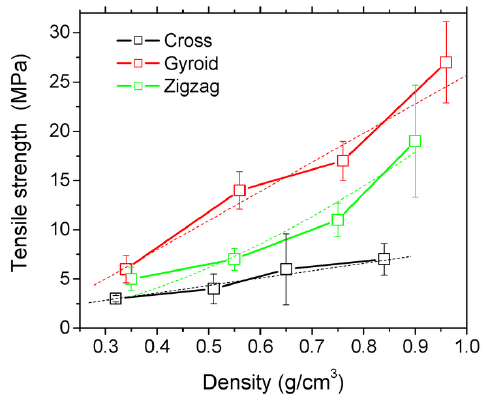
Figure 27. Correlations between engineering constants and the density of PLA–carbon fiber patterns with different infill densities ranging from 25% (point with lowest density) up to 100% at points with the highest material density [167].